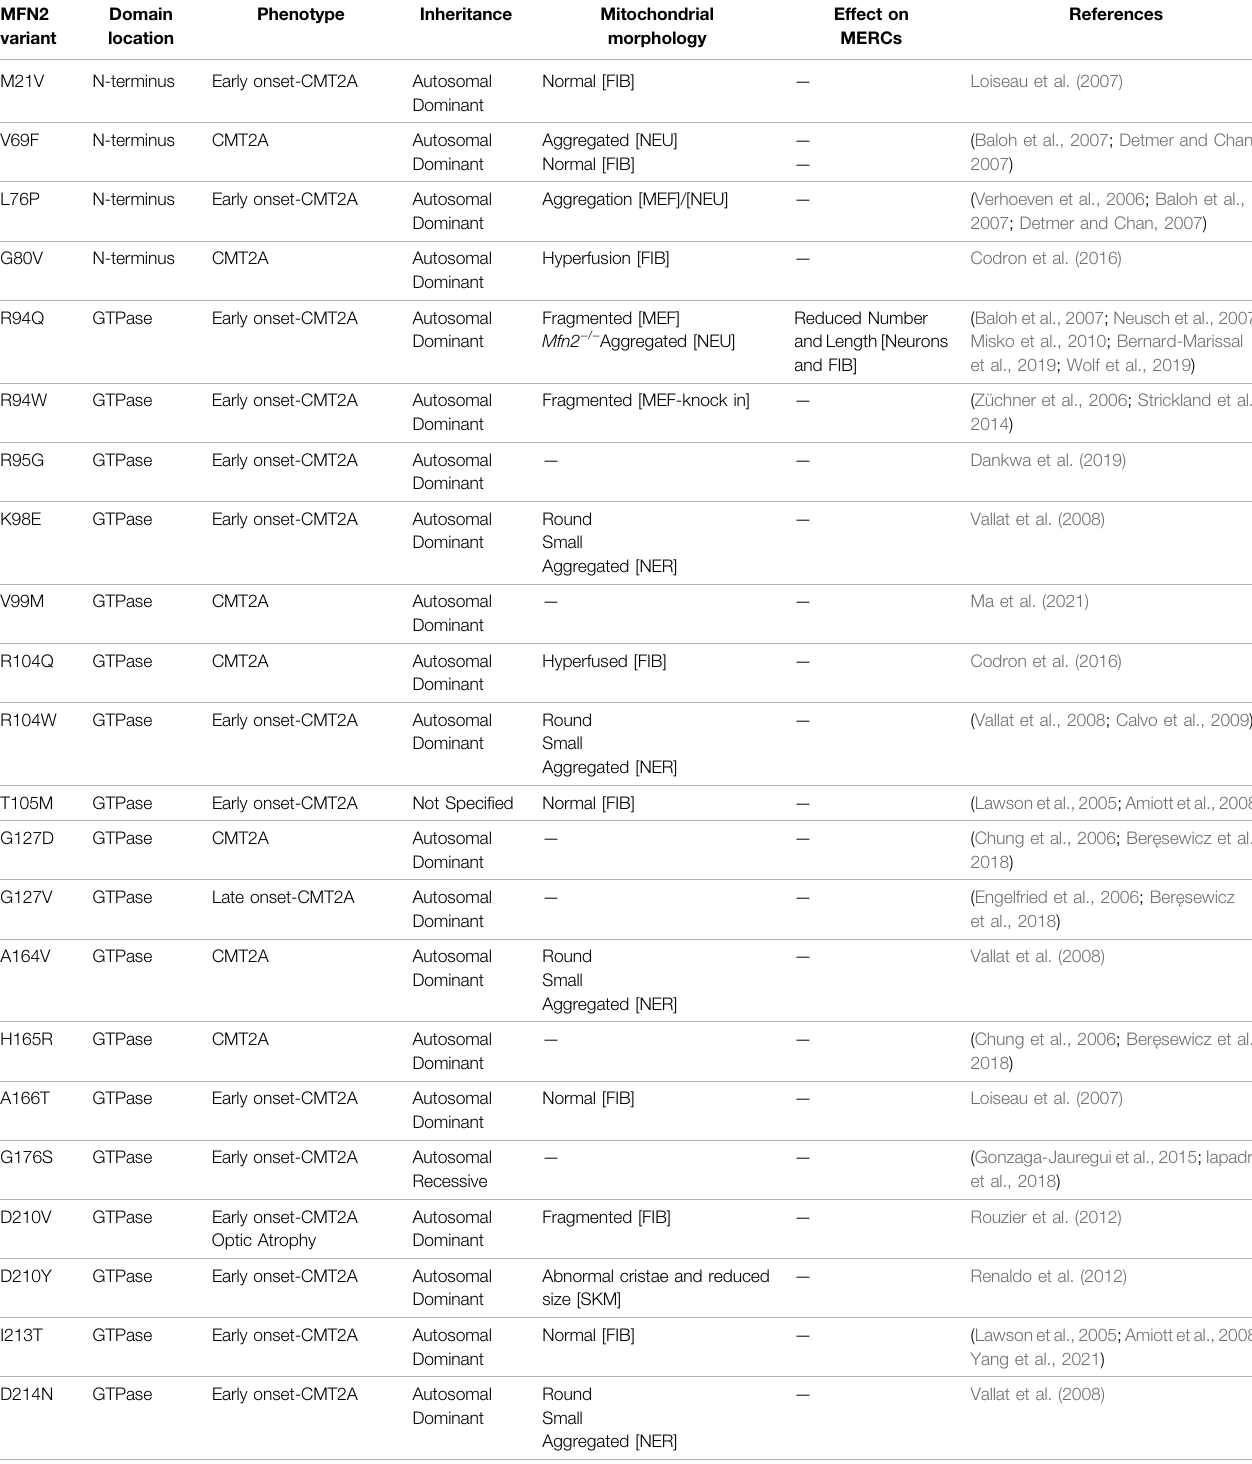
TABLE1| PathogenicMFN2variantsfunctionallycharacterizedfortheireffectsonmitochondrialmorphologyorMERCs.AlistofpathogenicMFN2variants, de fi nedbytheir aminoacidchanges,thathave been studied fortheireffectson mitochondrialmorphologyor MERCs.Associatedpatient phenotypes areindicated, andadescription of how mitochondrial morphology and MERCs are altered is provided. Unless otherwise speci fi ed, the cell type or tissue investigated are indicated as follows: Patient derived fi broblasts [FIB]; mouse embryonic fi broblasts with Mfn1/Mfn2 double KO and variant re-expressed [MEF]; myelinated and non-myelinated nerve [NER]; skin and muscle biopsy samples [SKM]. re-expression in rat neurons [NEU]. Relevant references are